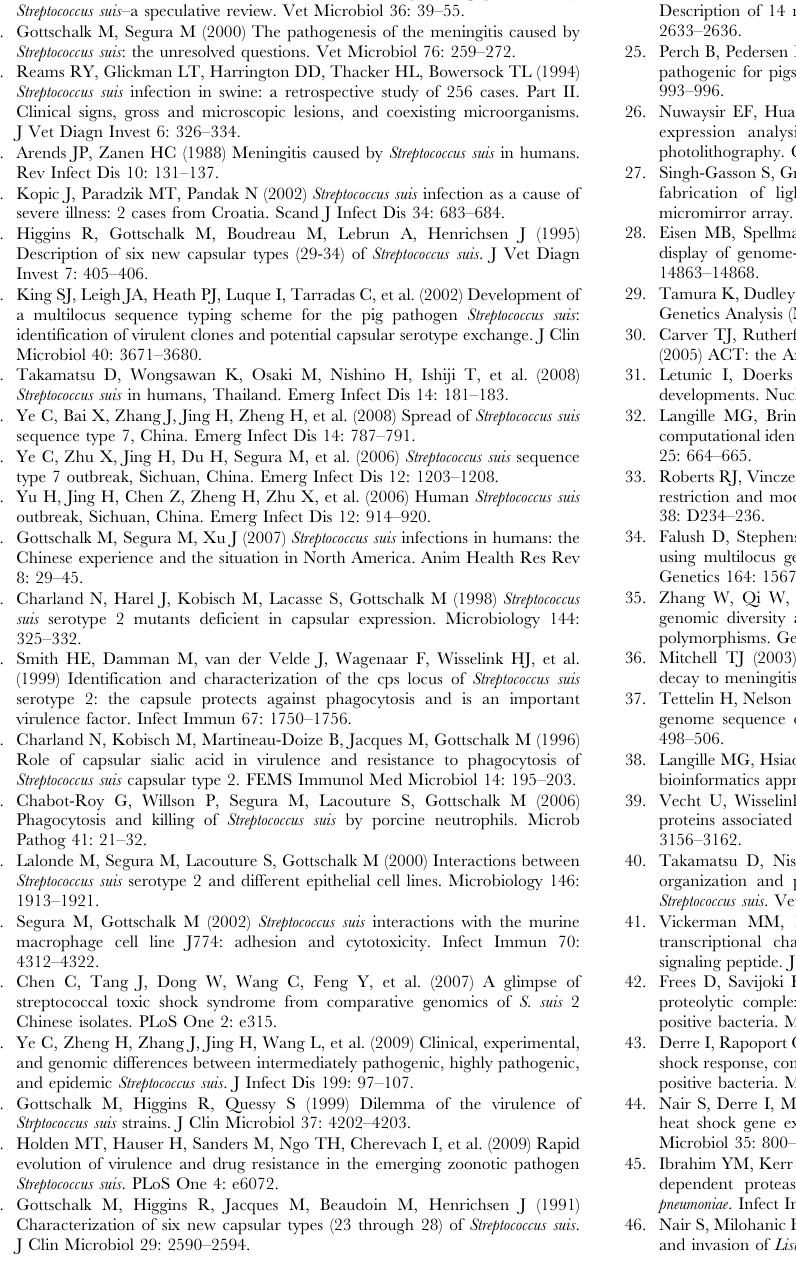
Table S4 Characteristics of putative genomic islands. GI features for 26 regions of difference (RDs) are described.